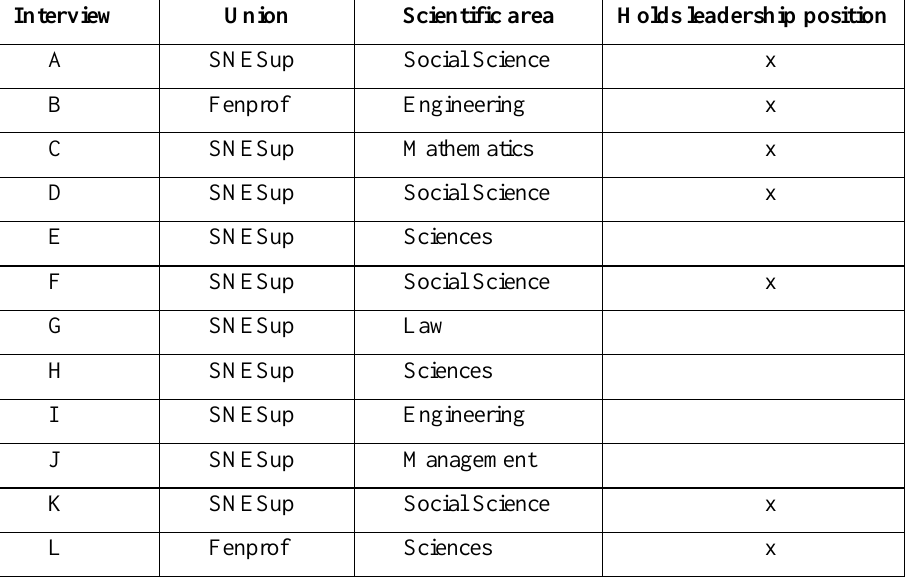
Table 3 Identification of union interviewees cited in the